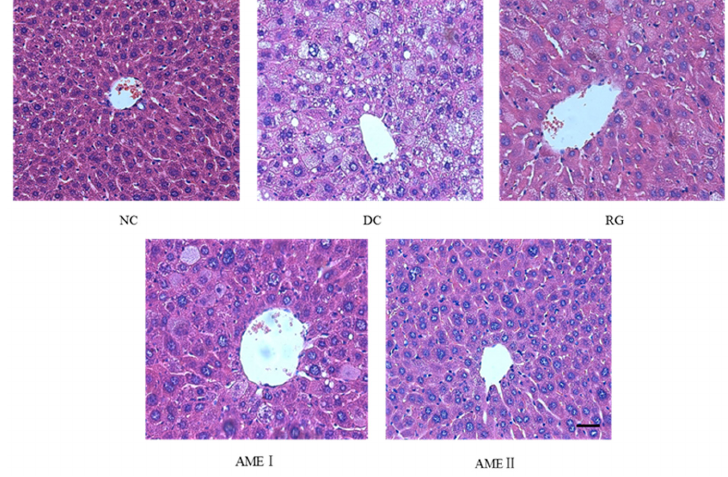
Figure 1. Effects of AME on hepatic steatosis in mice. The tissues were surgically excised and subjected to histological study by staining with hematoxylin and eosin. Magnification: 400 × . The scale bar represents a length of 20 μ m.